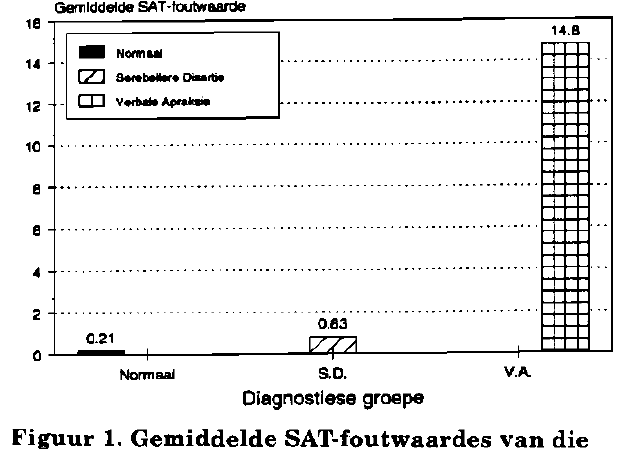
Figuur 1. Gemiddelde SAT-foutwaardes van die ' onderskeie diagnostiese groepe. /